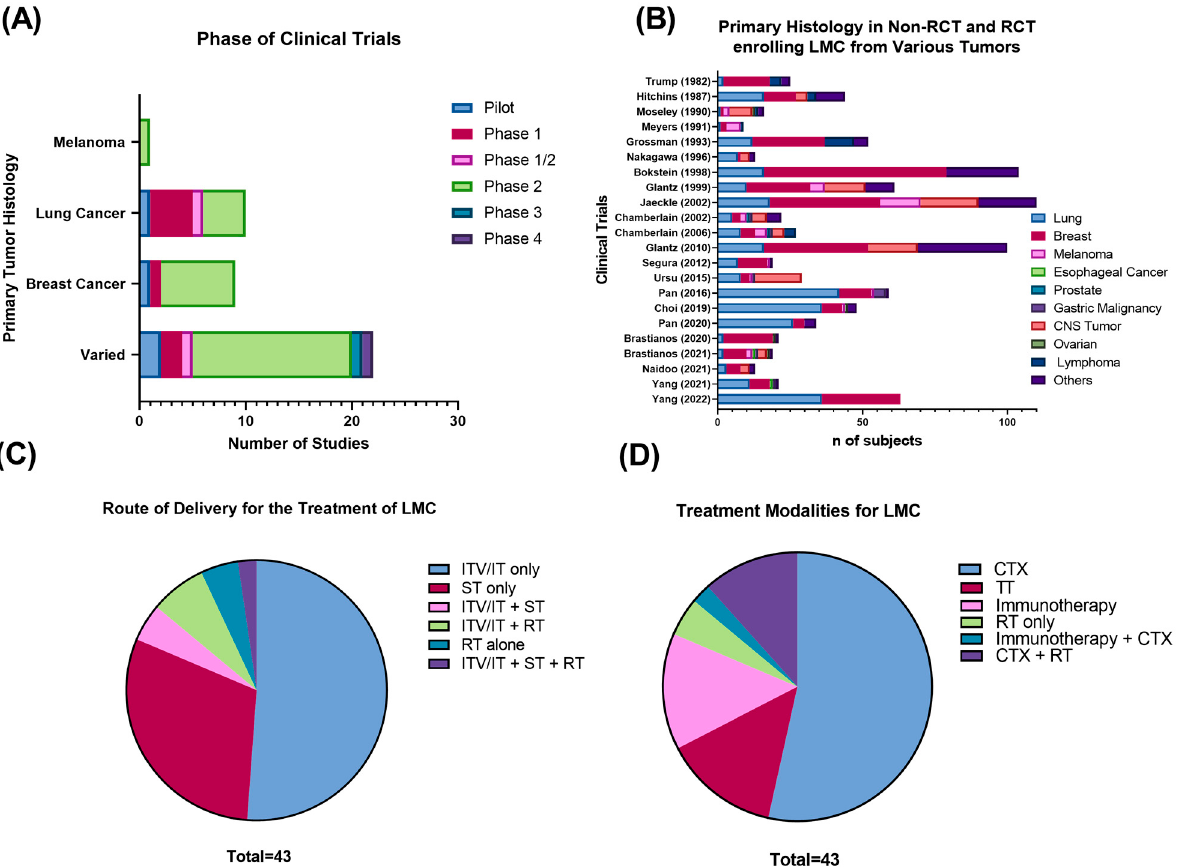
Figure 2. ( A ) Phase of clinical trials of LMC from solid tumors included in the systematic review. ( B ) Primary tumor histology in non-RCT and RCT enrolling LMC from various types of tumors. ( C ) Route of administration and ( D ) treatment modality for published clinical trials of LMC from solid tumors. Abbreviations: CTX: cytotoxic chemotherapy; ITV: intraventricular; IT: intrathecal; LMC: leptomeningeal cancer; RT: radiotherapy; RCT: randomized controlled trial; TT: targeted therapy.